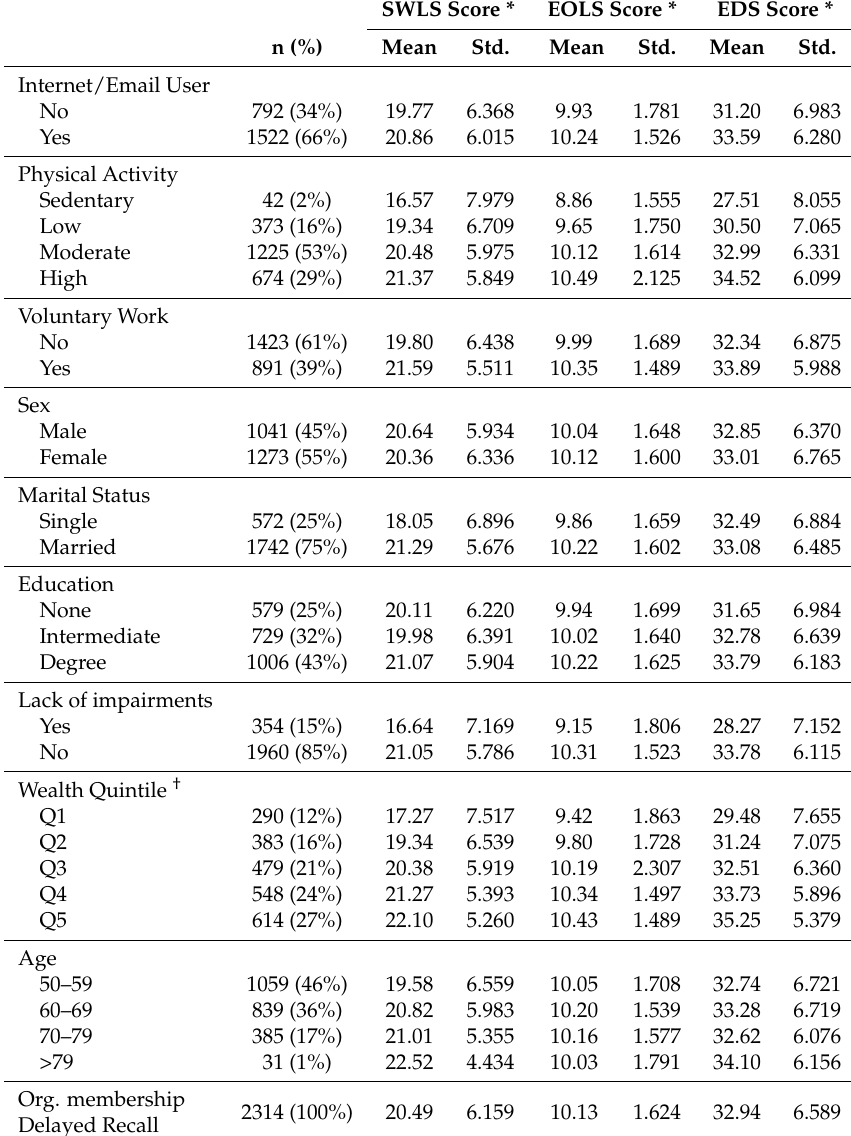
Table 3. Baseline characteristics of the analytical sample by psychological well-being indicator. English Longitudinal Study of Aging